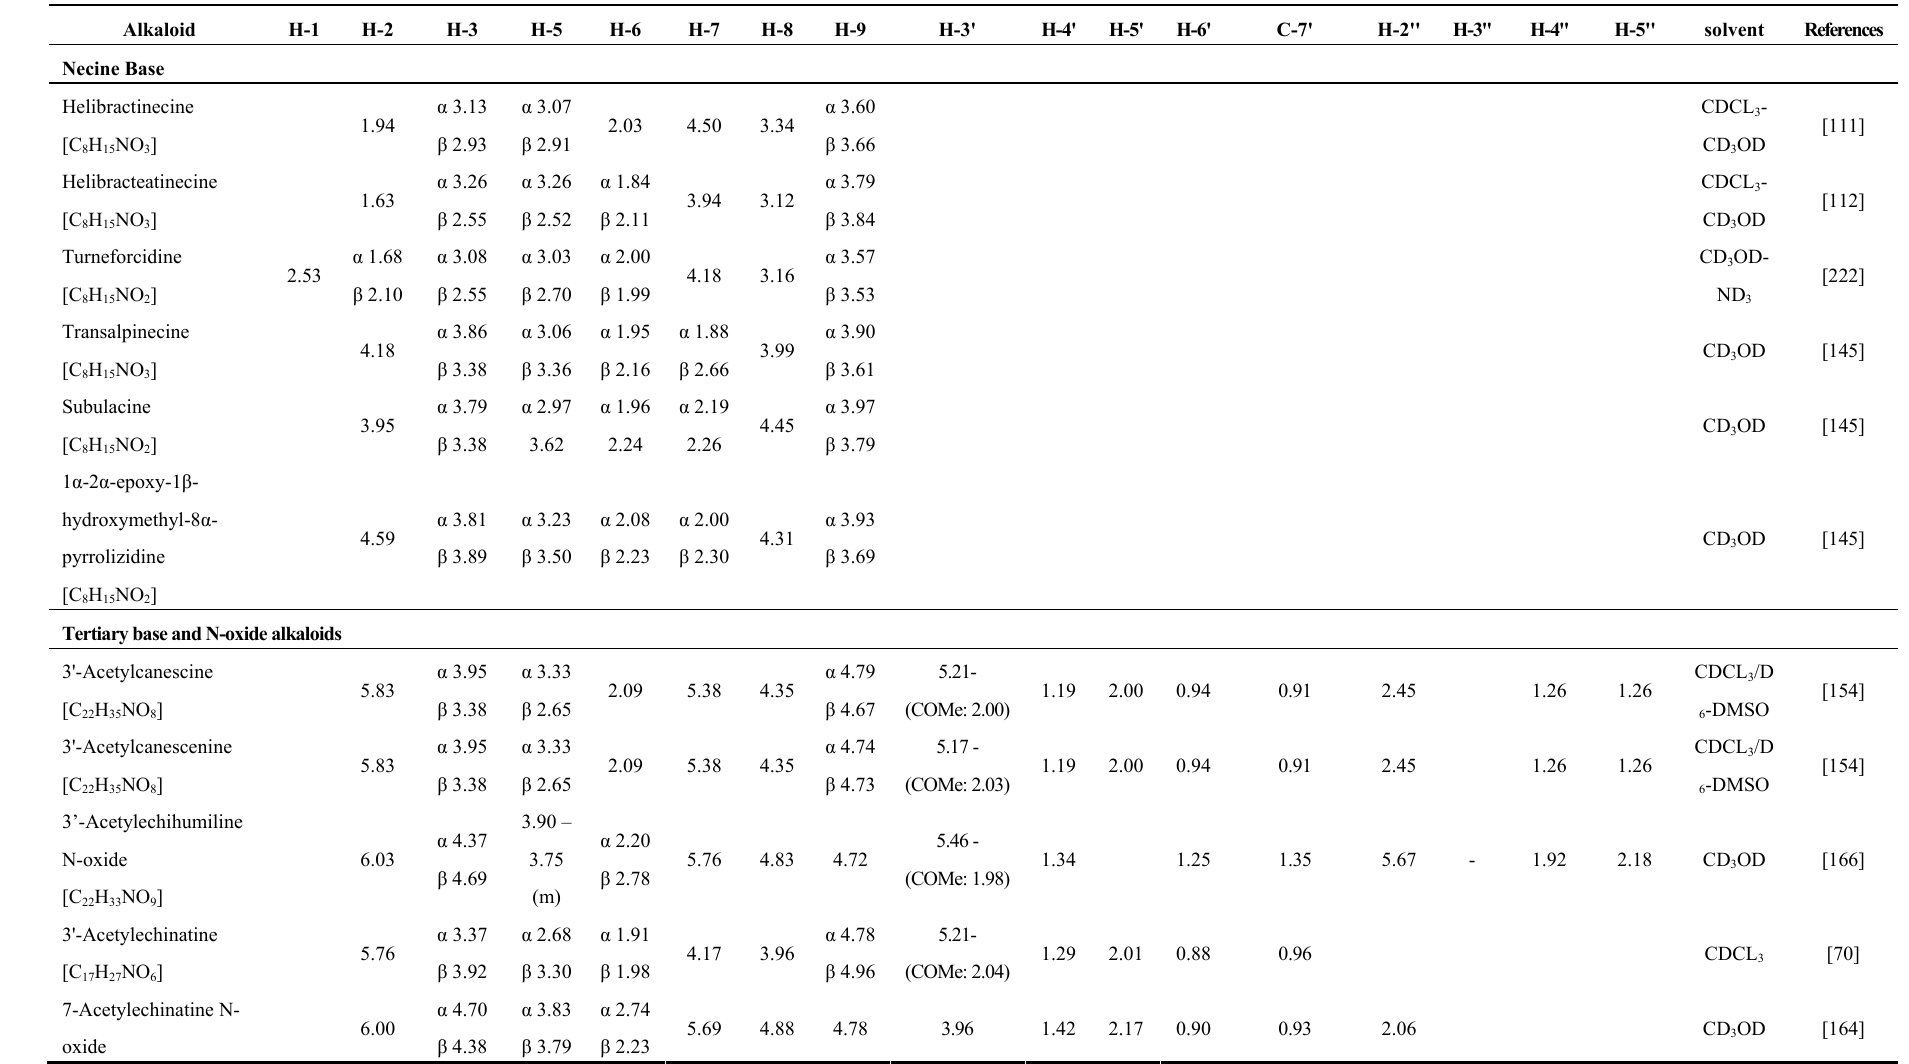
Table 5. 1 H NMR data of new PAs of in the time frame